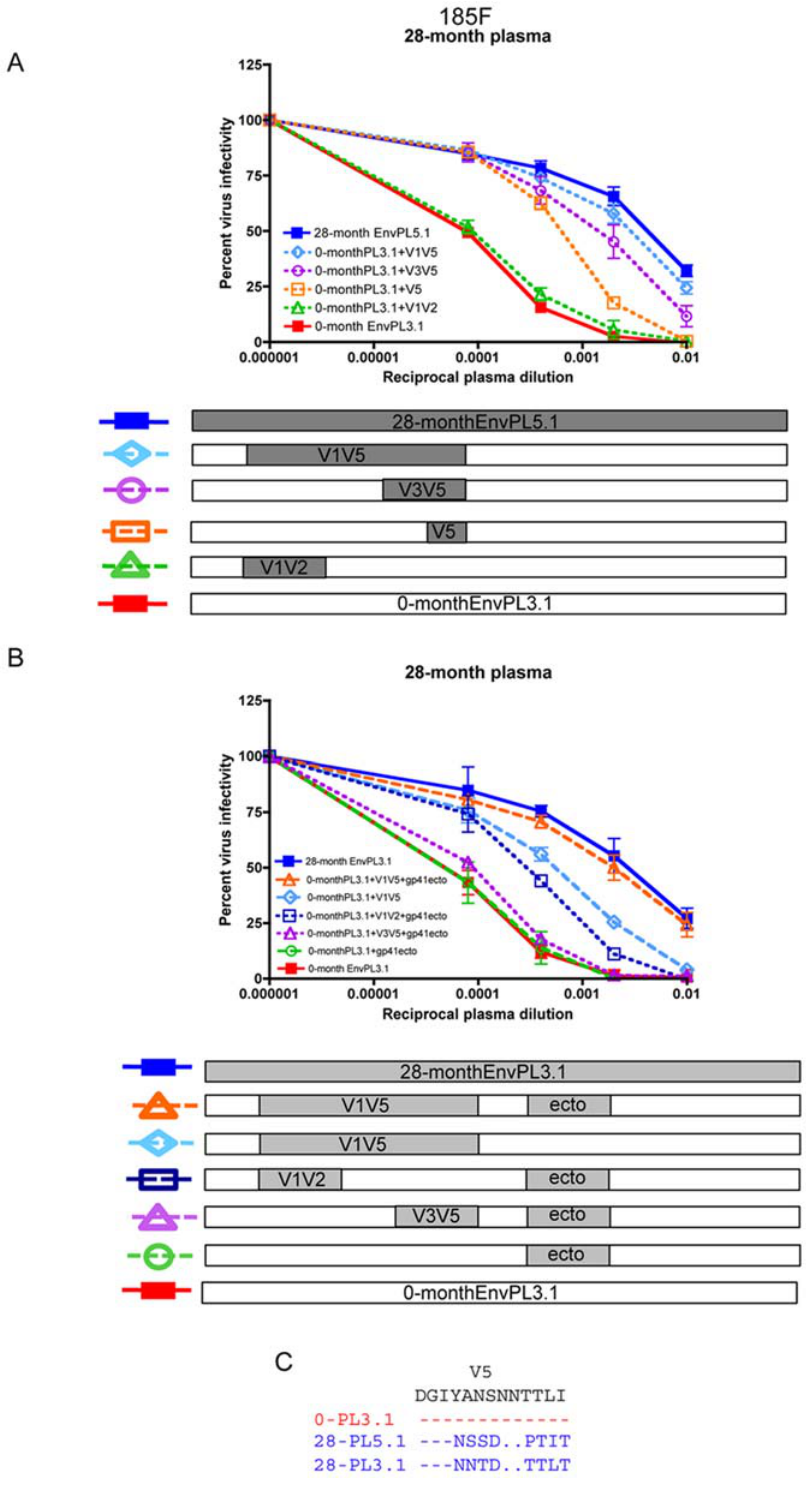
Figure 4. 185F Nab resistant variants at 28-months utilize distinct escape pathways. Neutralization of 28-month EnvPL5.1 (A) and 28- month EnvPL3.1 (B) and the chimeric Env pseudoviruses generated from each of these Envs in the 0-month Env background was evaluated using the 28-month plasma sample in JC53-BL13 cells with luciferase as a quantitative measure. Percent virus infectivity is plotted against the reciprocal of the log10 plasma dilution. Error bars represent the standard deviation of at least two independent experiments using duplicate wells. The panels below each graph indicate the region that was transferred from the 28-month Nab resistant Env (PL5.1 in A and PL3.1 in B; gray boxes) into 0-month EnvPL3.1 (white boxes). (C) Amino acid alignment of the V5 region for the 0-month and 28-month Envs.